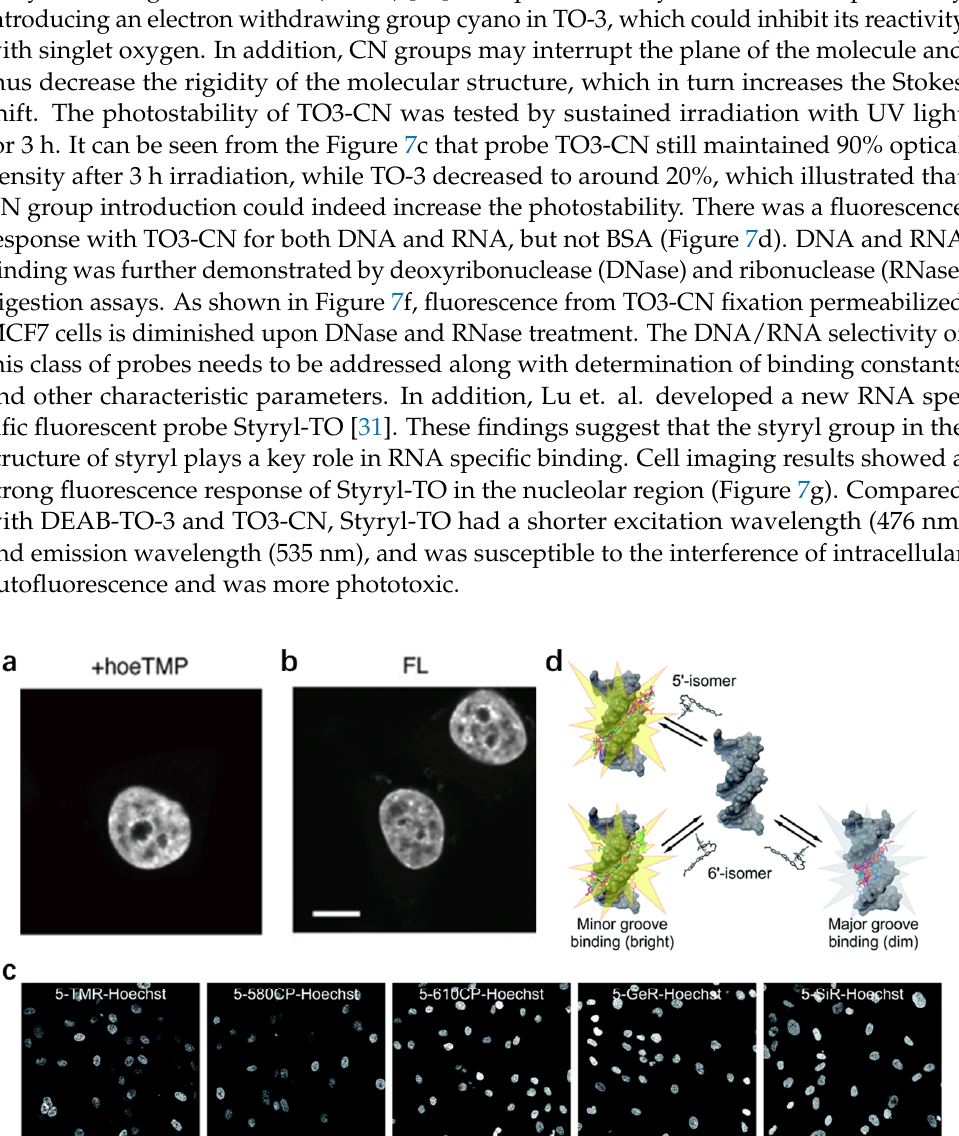
Figure 6. ( a , b ) Results of cell imaging of hoeTMP and hoeAc 2 FL, respectively. Reproduced from [12] and [25] with permission from the American Chemical Society, Copyright 2013 and Royal Society of Chemistry, Copyright 2014, respectively. ( c ) Confocal images of 5′-regioisomer and 6′-regioisomer. ( d ) Proposed model of rhodamine–Hoechst conjugate interaction with the target DNA. Minor groove binding results in a brighter complex compared to major groove binding. Reproduced from [27] with permission from the Royal Society of Chemistry, Copyright